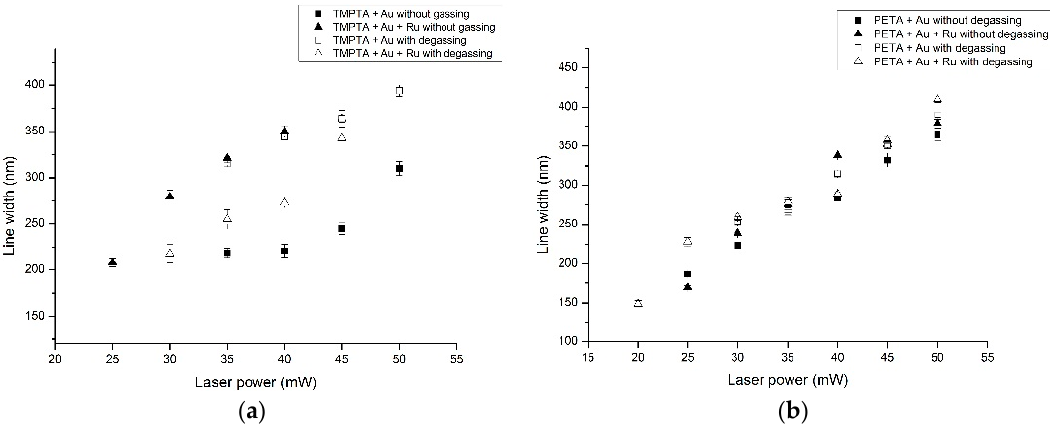
Figure 6. ( a ) Line width as a function of laser power for Formulation 2 and 3, with and without degassing and ( b ) line width as a function of laser power for Formulation 5 and 6, with and without degassing.